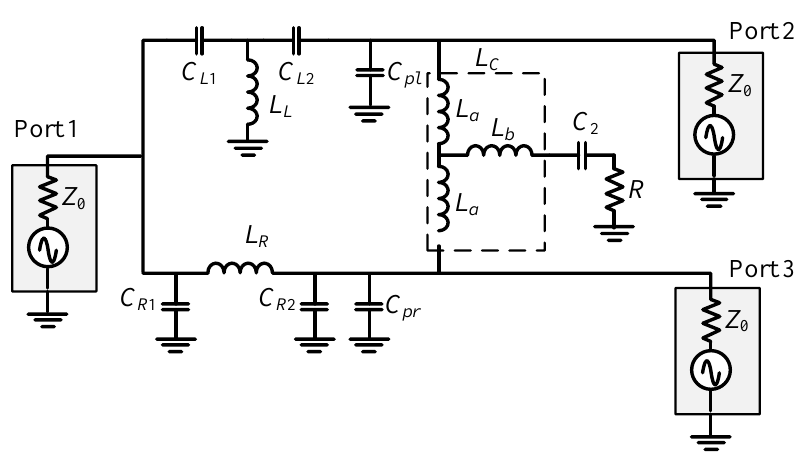
Figure 6. Schematic of the balun with a common inductor.